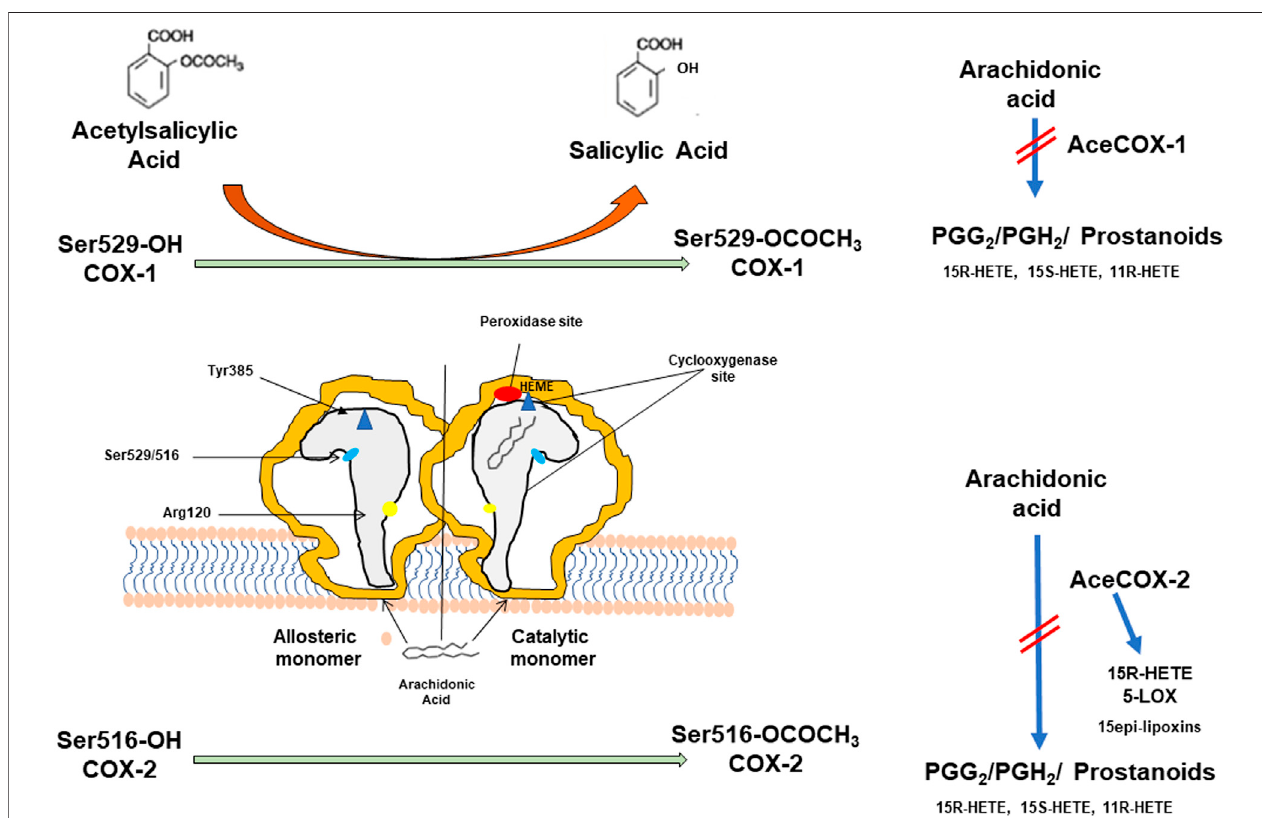
FIGURE1| Aspirin(acetylsalicylicacid,ASA)actsbyirreversiblyacetylatingcyclooxygenase(COX)-1andCOX-2.ProstaglandinHsynthase(PGHS)-1and-2(alsoknownas COX-1andCOX-2)aremicrosomalhomodimerichemeglycoproteinsthatcatalyzetwokeyreactionsinthebiosynthesisofprostanoids:thebis-dioxygenationofarachidonicacid to form PGG 2 (by the cyclooxygenase activity) and the reduction of PGG 2 to PGH 2 (by the peroxidase activity). In addition to PGH 2 , the monohydroxy acids 11(R)- hydroxyeicosatetraenoicacid11(R)-hydroxyeicosatetraenoicacid11R-(HETE),15S-HETE,and15R-HETEaregeneratedasminorproductsofthecyclooxygenasereaction. COX-isozymes function as conformational heterodimers comprised of a regulatory allosteric monomer and a catalytic monomer. The catalytic monomer has a bound heme, whereas the allosteric monomer does not. The cyclooxygenase active site is a hydrophobic channel (reported in grey), and Arg-120 is located near its mouth. Arg-120 forms an ionicbondwiththecarboxylategroupofarachidonate,andthisinteractionisanimportantcontributortotheoverallstrengthofarachidonatebindingtoCOX-1morethanCOX-2.